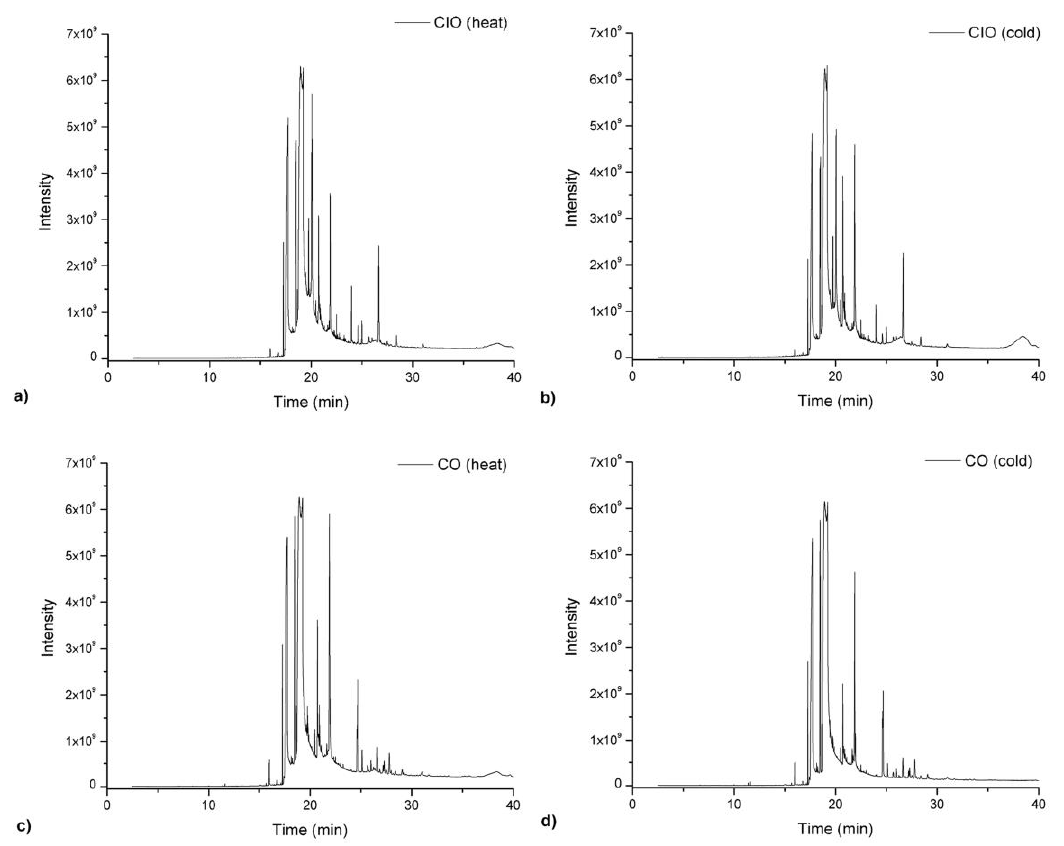
Figure 6. GC–MS chromatogram of CIO and CO after ( a , b ) and before ( c , d ) heating process, respectively. Di ff erences in the GC-MS chromatograms obtained for CIO and CO before and after heating